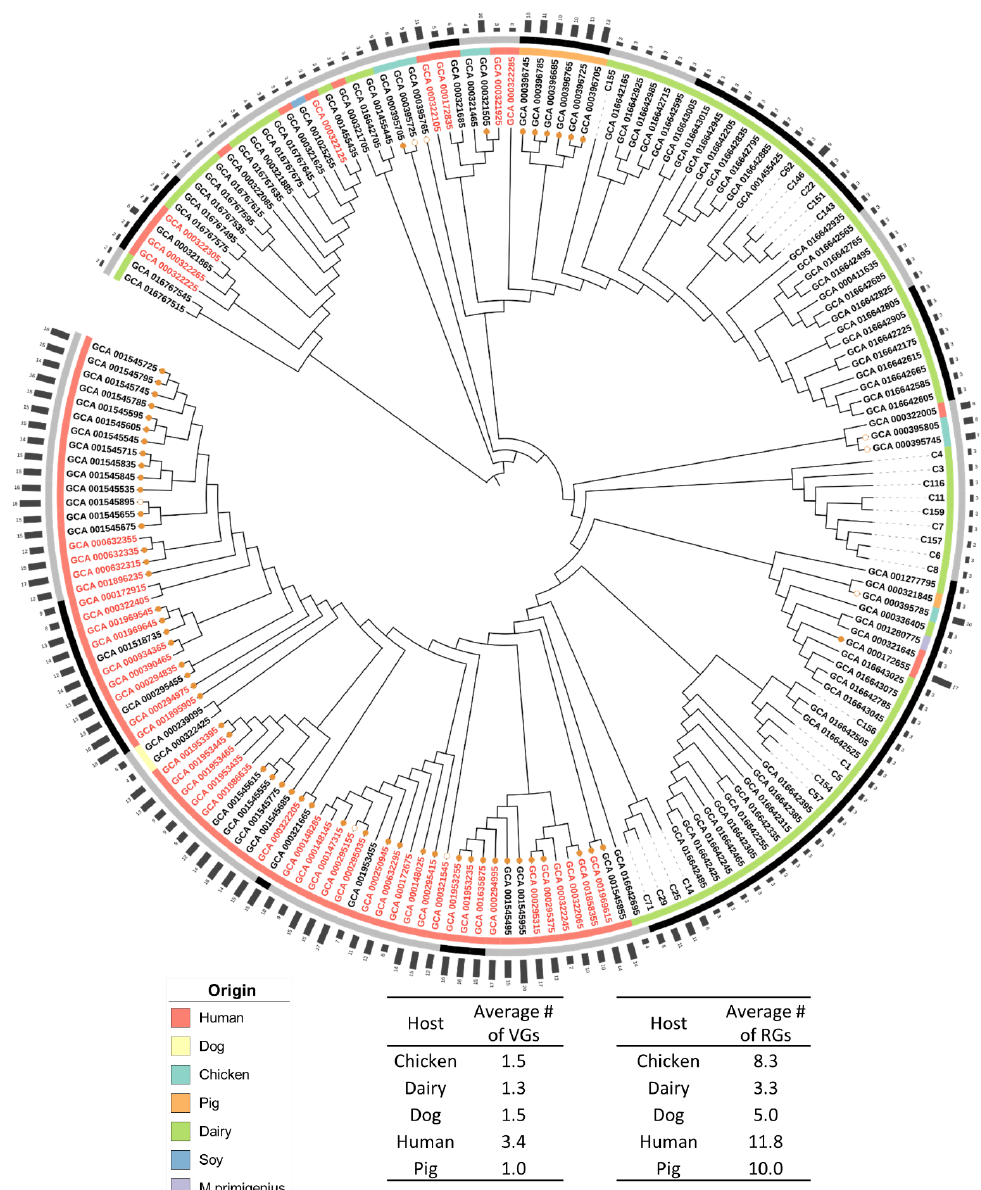
Figure 4. Phylogenetic tree including the 24 E. faecium dairy isolates of this study and 161 isolates from various origins, parsed from NCBI. The outer bar graph denotes the abundance of RGs found in each strain. Alternating dark and light grey segments in the outer ring mark different hierBAPS clusters. The colored inner ring indicates the isolates’ origin according to the legend. Isolate labels with red font signify human clinical isolates form cases of bloodstream and urinary tract infections. The outlined, filled or absent orange circle at the tree’s leaves, shows whether an isolate carried vancomycin-resistance regulator gene(s) ( vanR -like) only, regulator and vancomycin-resistance gene(s) ( van -like), or no vancomycin-related genes, respectively. The isolate labels of this study and of those retrieved from NCBI have a “C” and “GCA_” numerical prefix, respectively. #, number of the respective